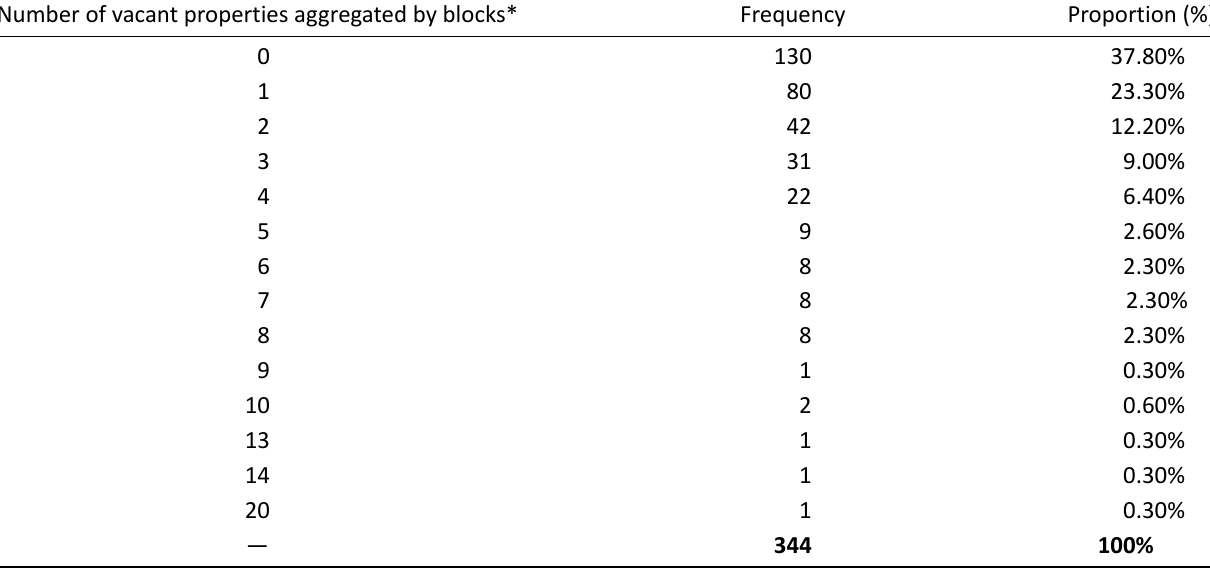
Table 3. Vacant properties identified through fieldwork aggregated by blocks. Number of vacant properties aggregated by